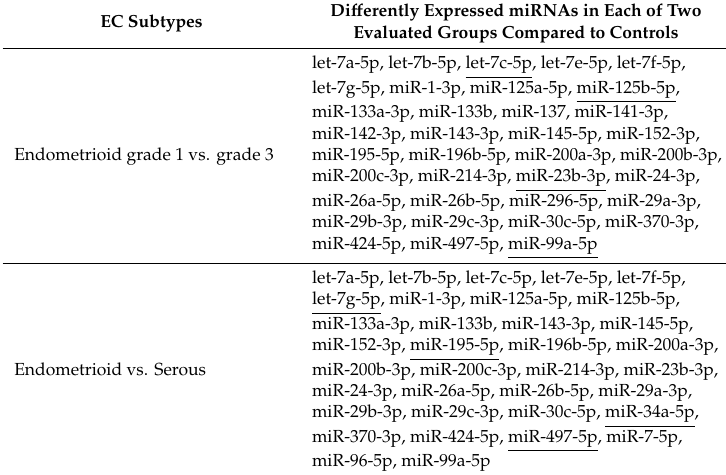
Table 1. Di ff erentially expressed miRNAs in EC subtypes. EC